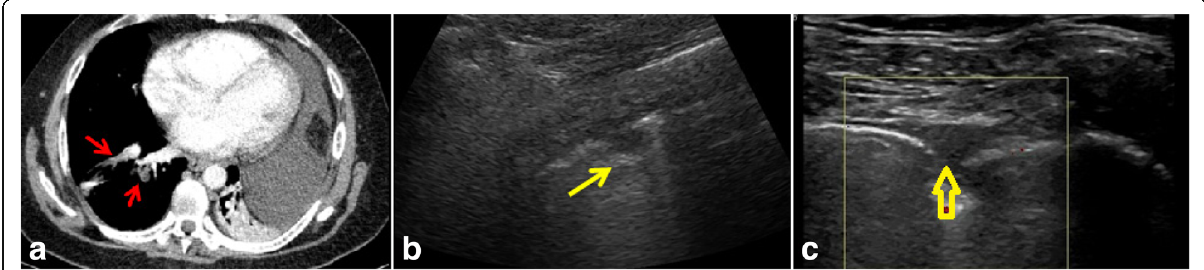
Fig. 5 CT pulmonary angiography ( a ) and ultrasound ( b , c ) images. a An axial section in the mediastinal window showing right lateral basal segmental branch dilatation with a filling defect seen inside and associated with a distal infarction ( red arrows ). b A right lower lung polygonal pleural-based hypoechoic lesion ( yellow arrow ). c A color Doppler image showing no detectable internal vascularity ( open yellow arrow